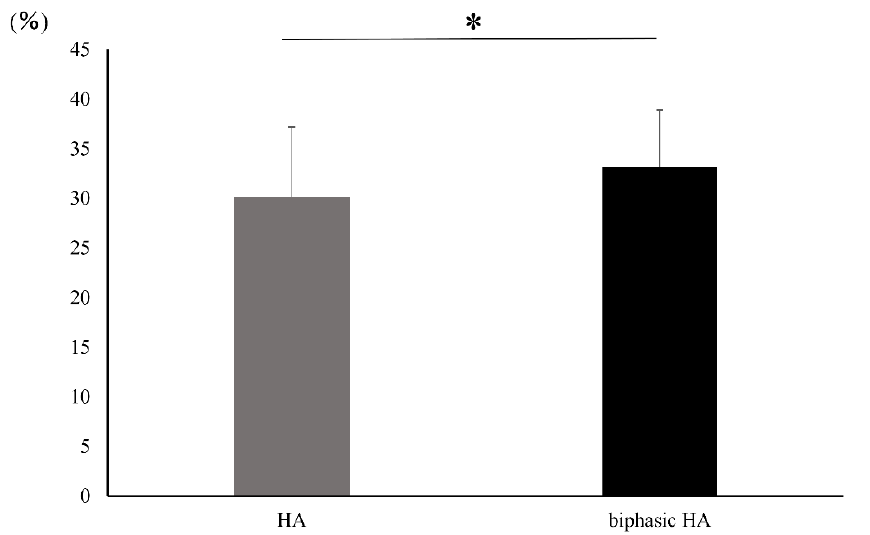
Figure 10. Volumes of HA granules and newly formed bone in ROI (n = 7).